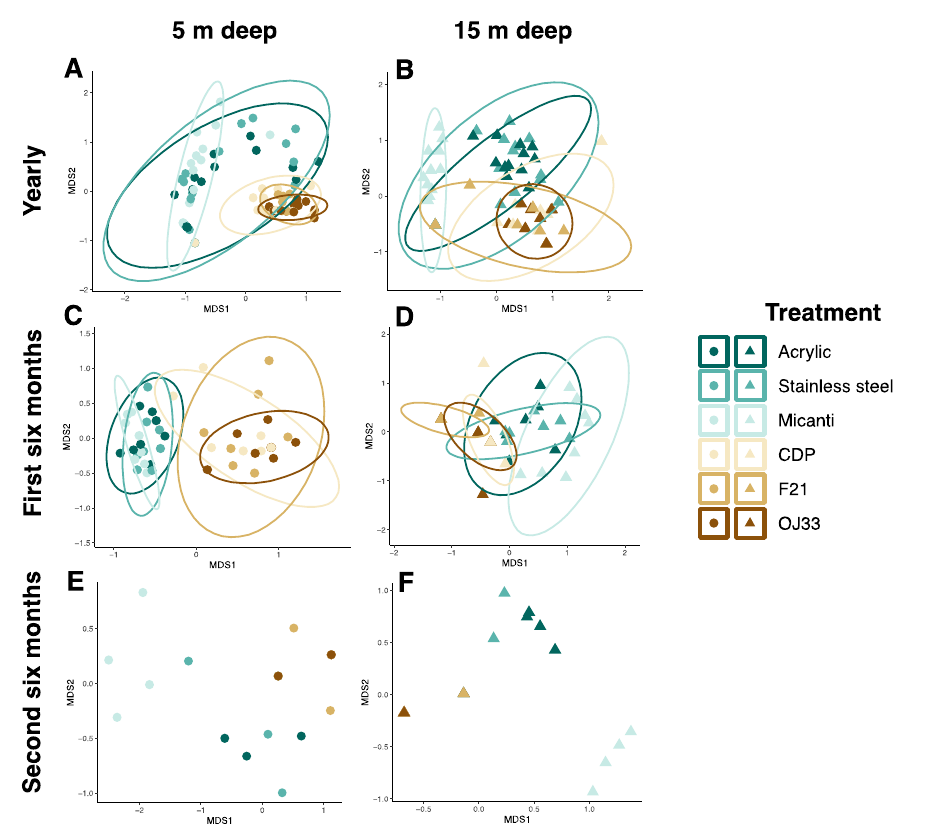
Figure 7. Compositional similarity of the different treatments, that include traditional materials, “eco-friendly”, and not eco-friendly AF strategies. Non-metric multidimensional scaling (NMDS) ordination plots based on abundance data using Bray–Curtis distances at two depths: 5 m deep ( A ) during 12 months of exposure (stress = 0.139), ( C ) first (stress = 0.110) and ( E ) second 6 months of exposure (stress = 0.044), and 15 m ( B ) during 12 months of exposure (stress = 0.121) and ( D ) first (stress = 0.140) and ( F ) second 6 months of exposure (stress = 0.038). The shape represents the different depths (circles for 5 m, triangles for 15 m), surrounded by the ellipse of the 95% confidence interval. We also found significant differences for richness ( p = 0.004) and diversity ( p <